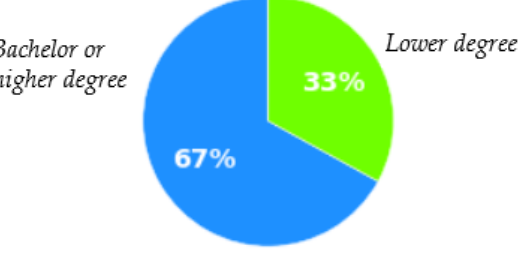
Figure 3. Respondents for question of do you hold a bachelor or higher degree? A total of 53% of the respondents have experience with operating financial derivatives, including stocks and options, while 47% of the respondents did not have this experience (Figure 4, Table